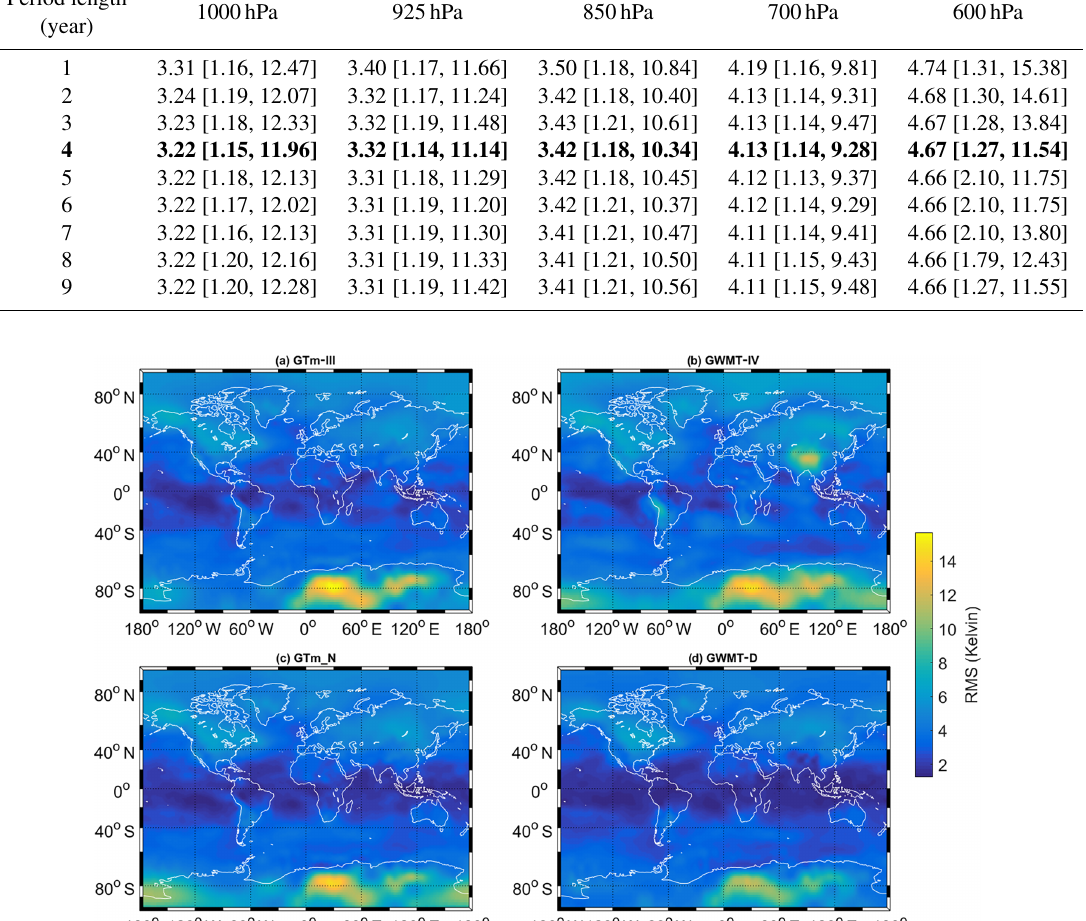
Figure 5. The global RMSE distribution of the differences between the T m derived from each model and the NCEP2 data on pressure level of 925hPa in